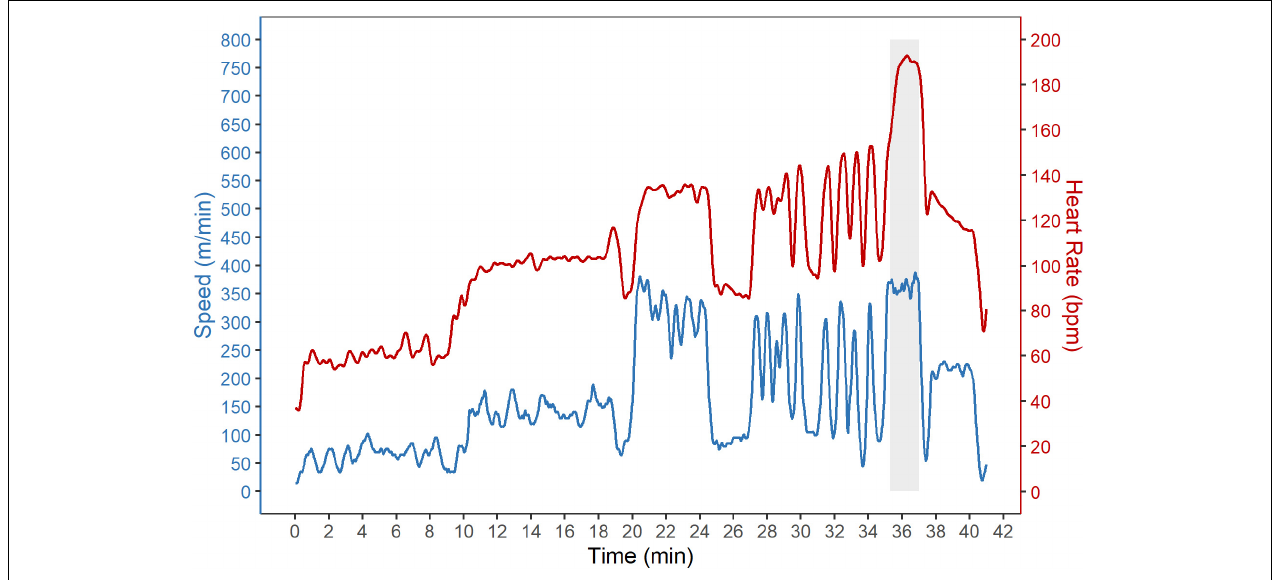
FIGURE 2 | Standardized show jumping course (SET course ). Speed (blue) and heart rate (red) during the standardized show-jumping course (SET course ) are shown exemplary for one horse. The SET course consisted of a warm-up phase followed by a standardized show-jumping course with 13 (group A) or 16 (group B and C) fences. The show-jumping course is indicated by a gray